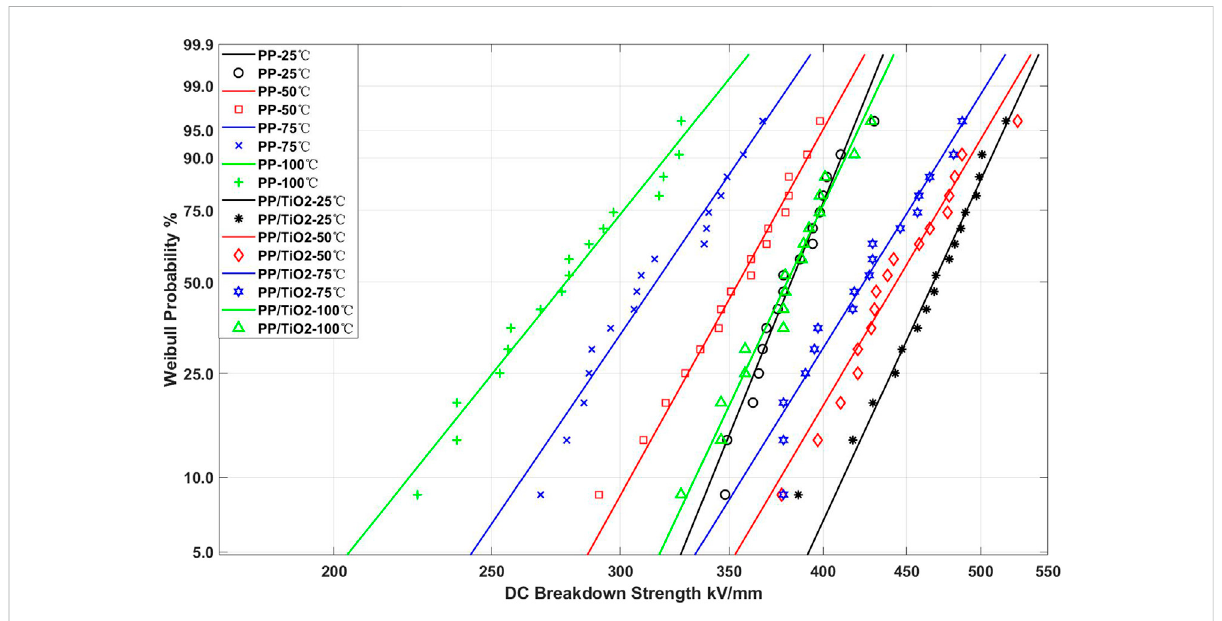
FIGURE 7 Weibull plots of DC breakdown strength at different temperatures.